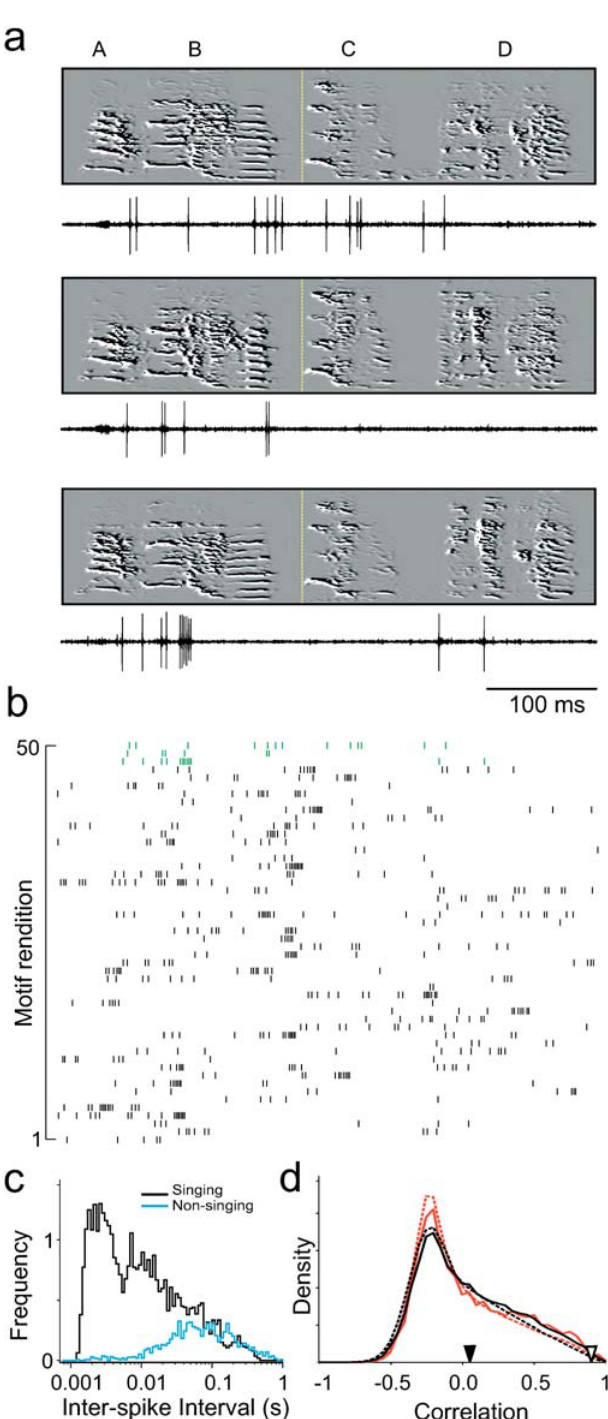
Figure 3. Song-Aligned Firing Patterns of RA-Projecting LMAN Neurons in Singing Juvenile Zebra Finches Are Highly Variable (A) Three successive renditions of a 67-d-old bird’s song motif. Displayed under each spectrogram is the simultaneously recorded voltage waveform of an antidromically identified RA-projecting LMAN neuron (verified by collision testing). Average syllable variability for the three motifs is 0.31. Motif alignment was done at the onset (yellow lines) of syllable C. (B) Raster plot showing the spike patterns for 50 consecutive motif renditions for the same cell as in (A). The motifs from (A) are indicated in green. (C) Relative frequency of inter-spike intervals during singing